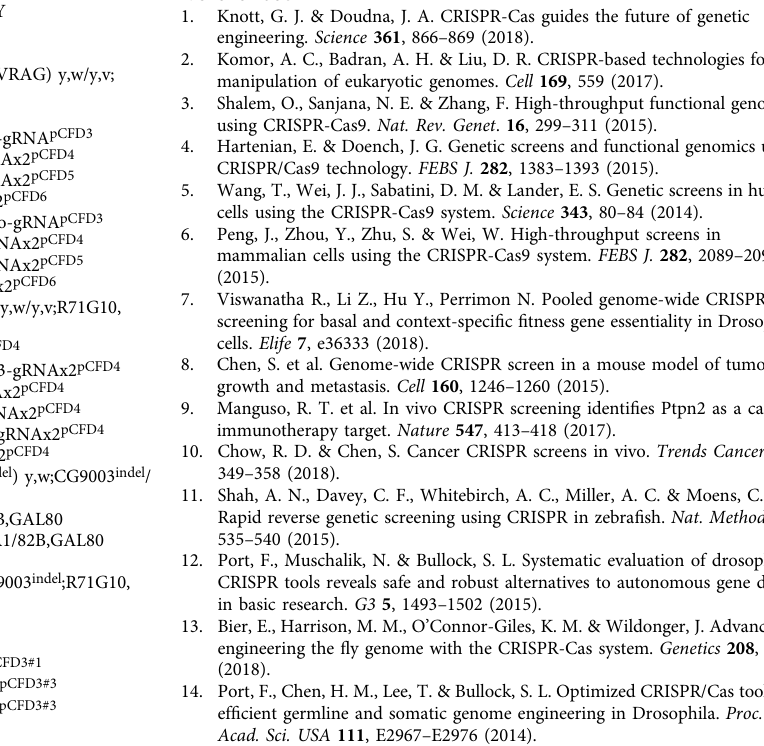
Figure 2a. (pCFD3) y,w/y,v;R71G10,CD8/ + ; Cas9.C/Plum-gRNA pCFD3 (pCFD4) y,w/y,v;R71G10,CD8/ + ; Cas9.C/Plum-gRNAx2 pCFD4